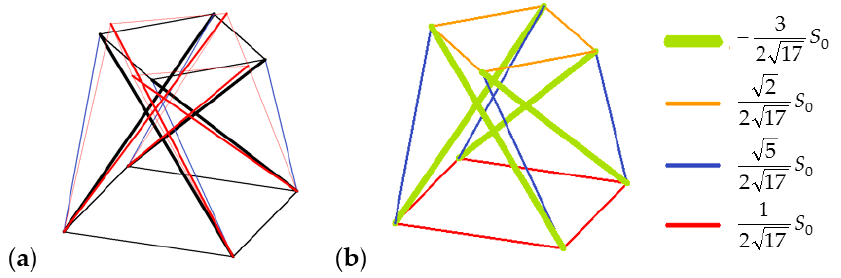
Figure 2. 4-strut simplex: ( a ) Infinitesimal mechanism; and ( b ) self-stress state.